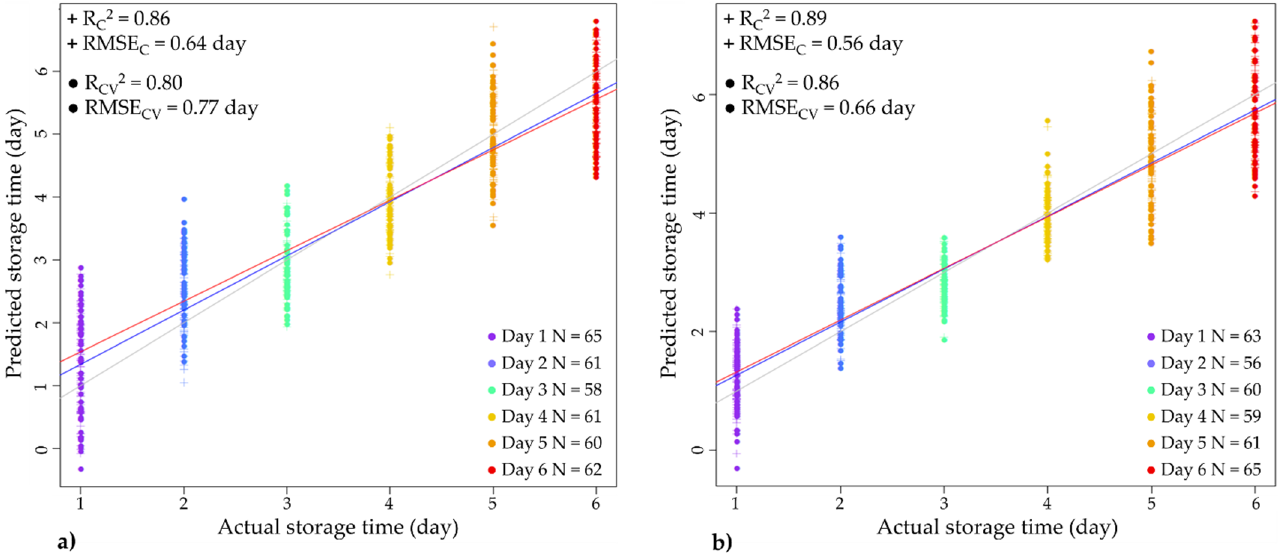
Figure 11. PLSR models for storage time prediction. ( a ) Agreement between the actual and predicted storage time (days) using the spectral data of inner leaves (deTr ‐ treated spectra, N = 367, NrLV = 9) and ( b ) agreement between the actual and predicted storage time (days) using the spectral data of outer leaves (deTr ‐ treated spectra, N = 364, NrLV = 9).